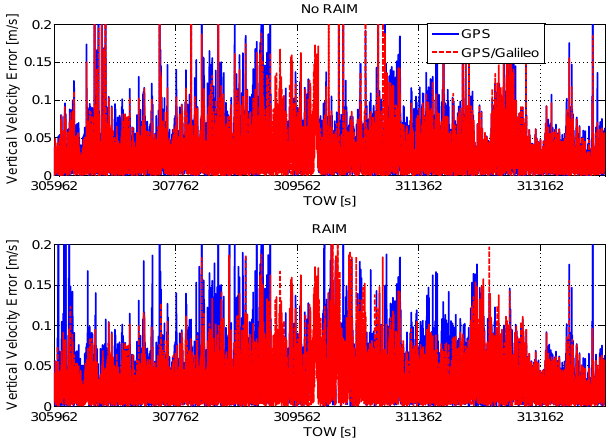
Figure 18. Vertical velocity errors as a function of time. Upper box: configurations without RAIM; lower box: configurations with RAIM.